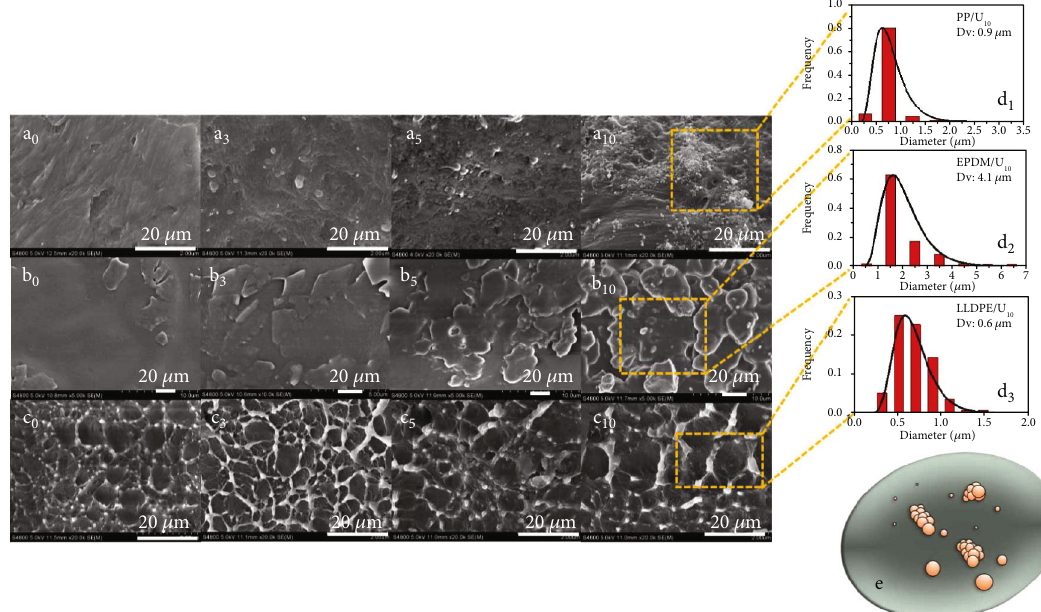
Figure 3: SEM images of fractured sections of three kinds of blends. (a ) LLDPE-U c 10 of polyole fi n with Dis-UHMWPE